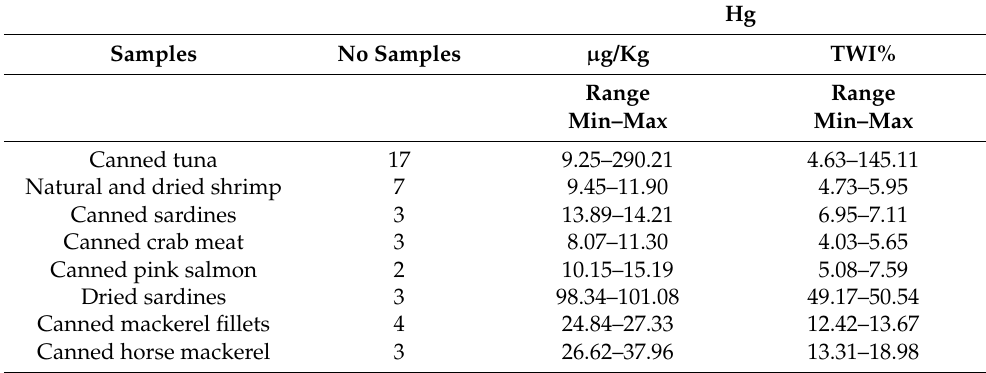
Table 3. Tolerable weekly intake (TWI) % values for Hg contents in analyzed processed fish and shellfish.